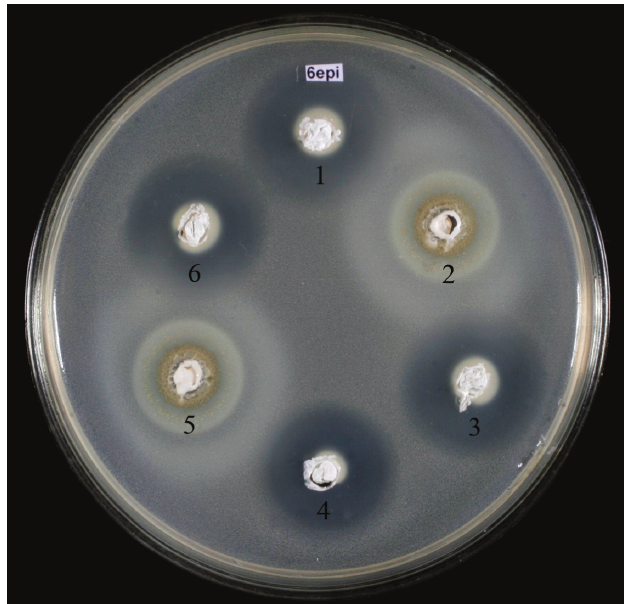
FIGURE 1 - Inhibition zones for S. epidermidis . 1: Paste A70D, 2: Ca(OH) , 3: Paste D70D, 4: Paste A70D, 5: Ca(OH) 2 6: Paste